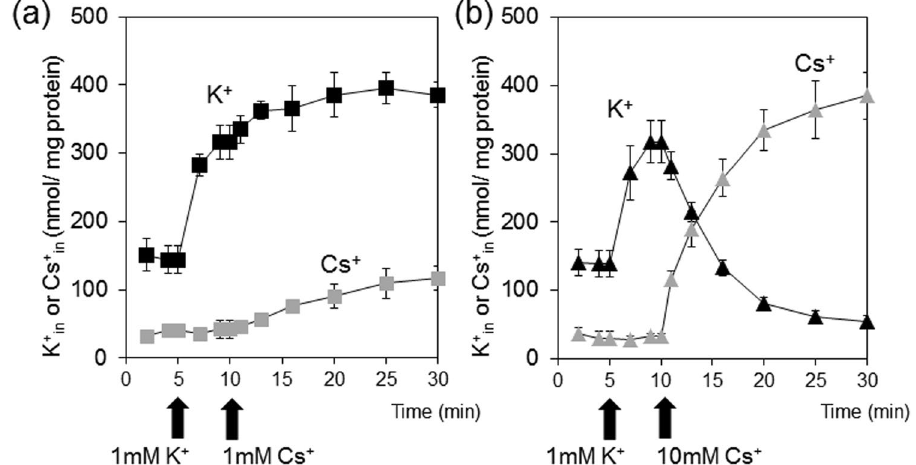
Figure 5. Loss of intracellular K + due to Kup-driven Cs + influx. The Cs + content (gray symbols) was determined from the same E . coli LB2003 expressing Kup cells shown in Fig. 4b. Final concentration of Cs + added in the medium was 1 mM ( a ) or 10 mM ( b ). The data representing K + content (black symbols) is shown here for comparison, it is the same as that in Fig. 4b. The error bars represent mean ± S.D. (n =